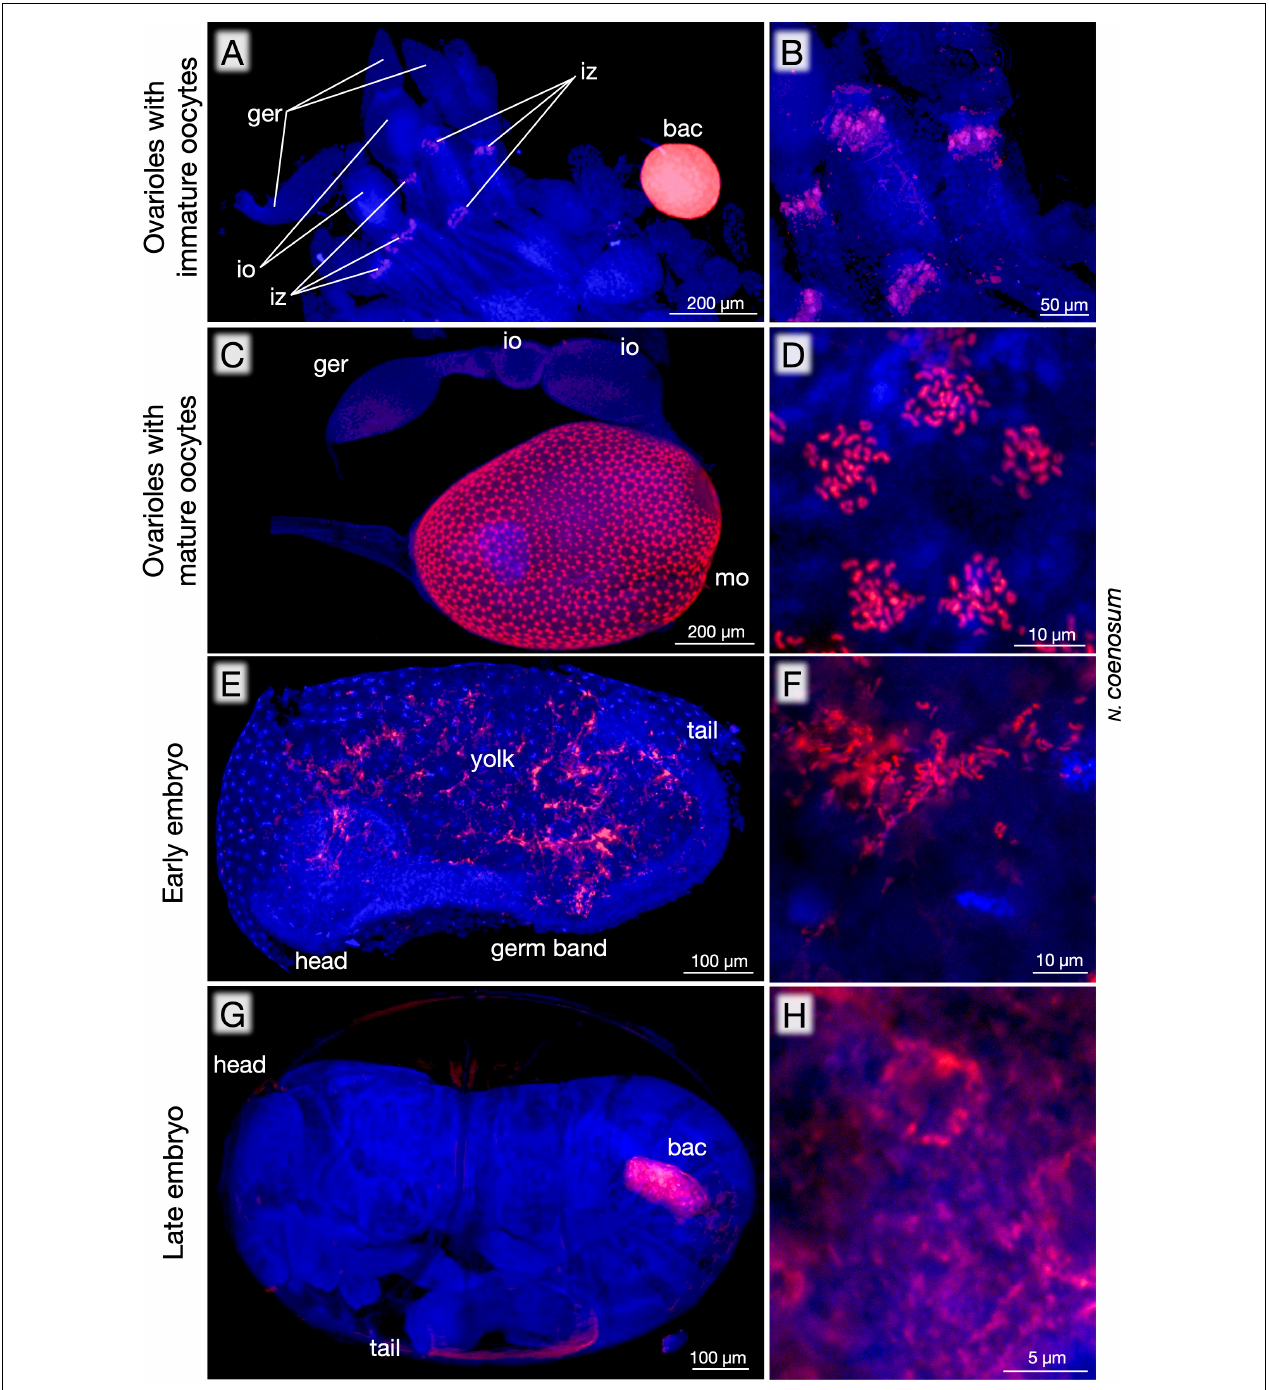
FIGURE 4 | Localization of endosymbiotic bacteria during oogenesis and embryogenesis of N. coenosum . (A) In ovarioles with immature oocytes, an infection zone for presumable entry region for the endosymbiotic bacteria is detected at the posterior side of the immature oocytes. Note the very strong FISH signal in the bacteriome, highlighting preferential localization of the endosymbiotic bacteria to the symbiotic organ. (B) Magnified image of the infection zones. (C) In ovarioles with growing oocytes, the egg surface exhibits dense and radial distribution patterns of the endosymbiotic bacteria. (D) Magnified image of the endosymbiont cells constituting a radial unit. (E) An early embryo, in which the endosymbiont cells are found in the yolk region outside the germ band. (F) Magnified image of the endosymbiont cells in the early embryo. (G) Side view of a late embryo, in which one of paired primordial bacteriomes is seen within the abdomen. (H) Magnified image of the endosymbiont cells in the late embryo. Red signals represent the endosymbiotic bacteria visualized by FISH targeting 16S rRNA, whereas blue signals show DNA visualized by DAPI staining. bac, bacteriome; ger, germarium; io, immature oocyte; iz, infection zone; mo, mature oocyte. Also see Supplementary Figure S2 for negative controls corresponding to (C)